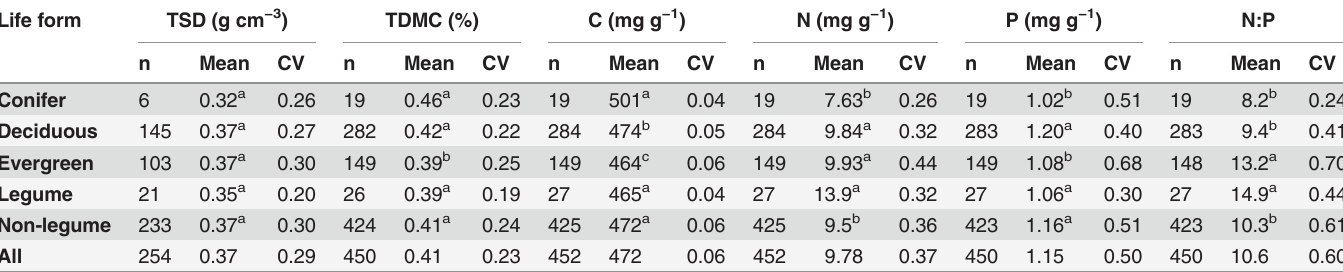
Table 1. Statistics for twig speci fi c density (TSD), dry matter content (TDMC), C, N, P and N:P of woody plants from 12 forest sites in eastern China.